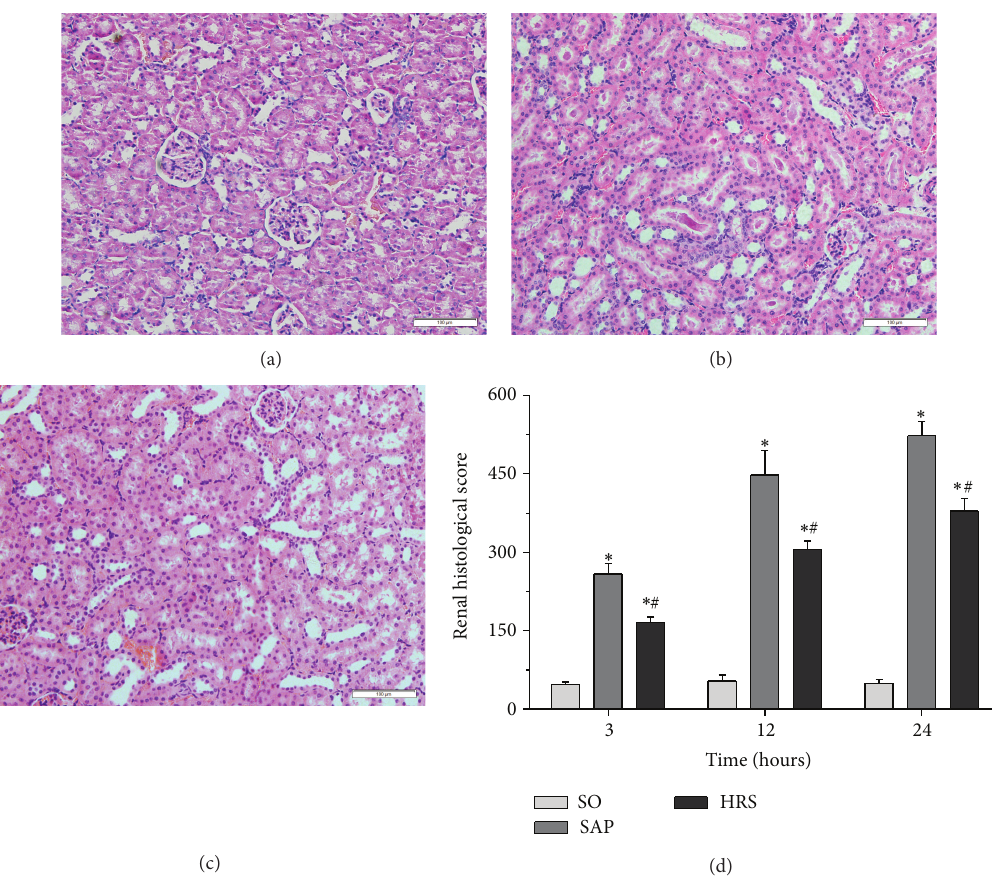
Figure 3: Morphologic changes of the kidney at 12 hours and the renal histological scores at each time point. (a) SO group, (b) SAP Group, (c) HRS group, and (d) the pathological scores of the kidney at each time points. ∗ 𝑃 < 0.05 versus SO group; # 𝑃 < 0.05 versus SAP